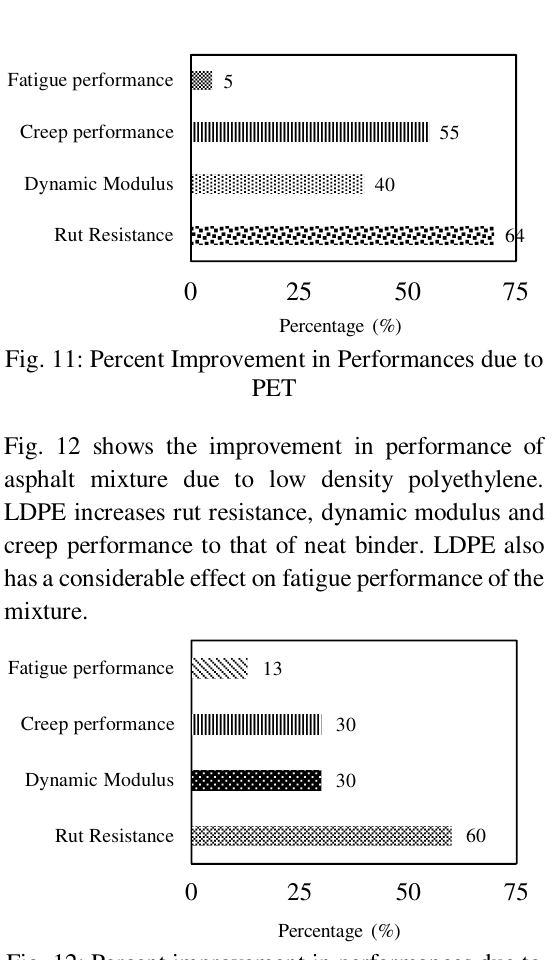
Fig. 12: Percent improvement in performances due to LDPE